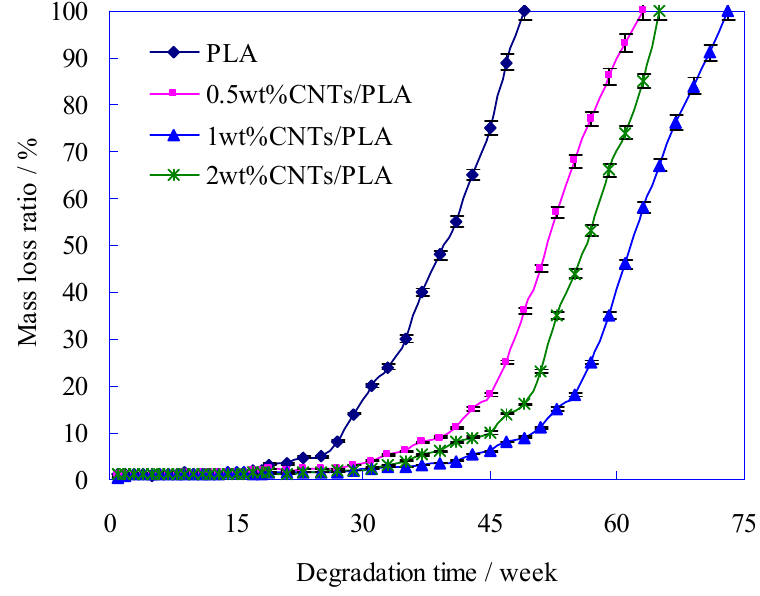
Figure 10. Change of mass loss ratio during degradation weeks.